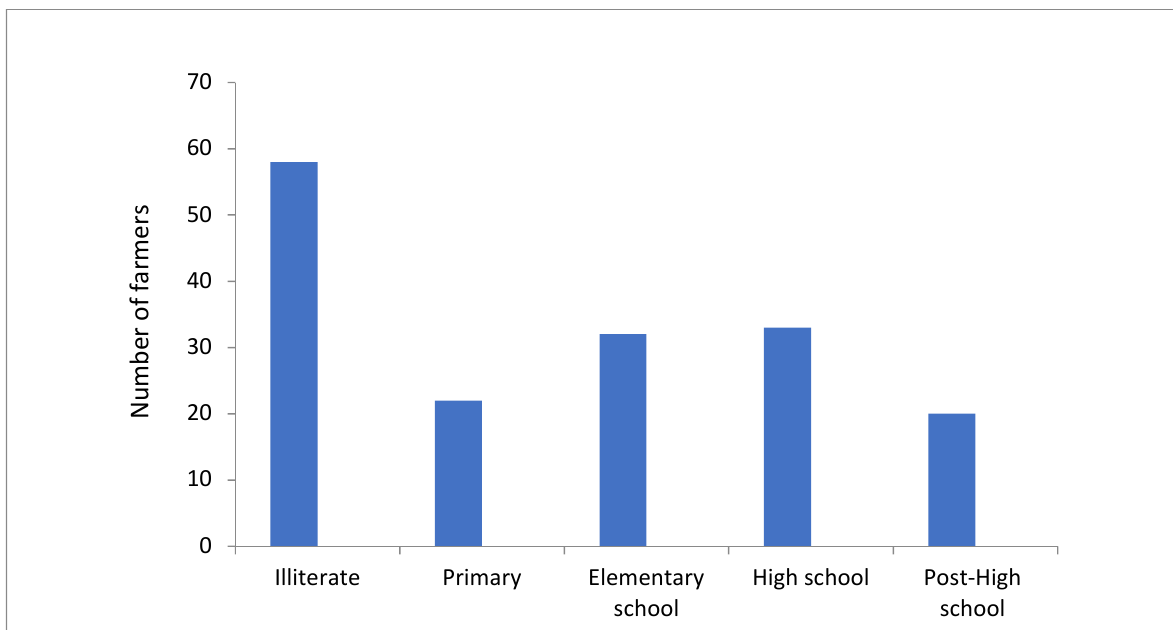
Figure 2. Education levels of the farmers interviewed.